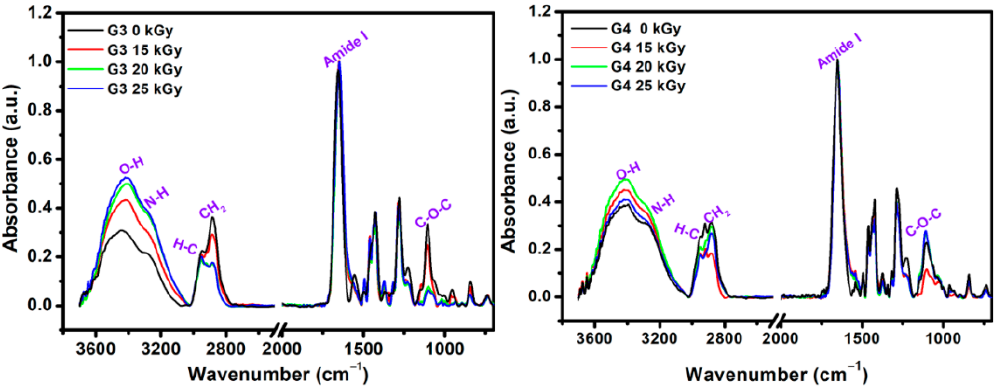
Figure 4. FTIR spectra of lyophilized G3 and G4